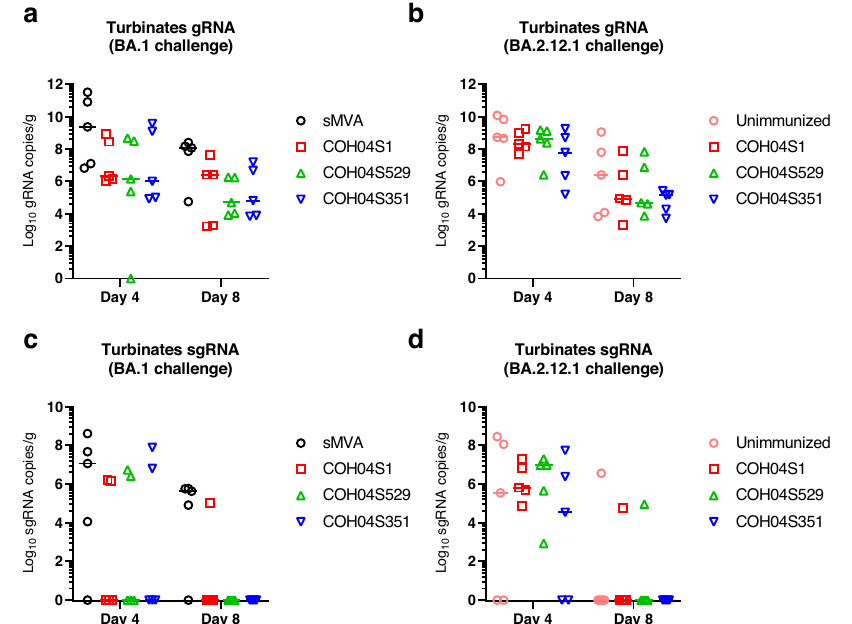
Fig. 4 Viral loads at upper respiratory tracts in COH04S1-, COH04S529-, and COH04S351-vaccinated hamsters following challenge with Omicron BA.1 or BA.2.12.1. SARS-CoV-2 genomic RNA (gRNA, a , b ) and sub-genomic RNA (sgRNA, c , d ) copies were quanti fi ed by qPCR in nasal turbinates of COH04S1, COH04S529, and COH04S351 vaccine and control groups at days 4 and 8 following challenge with Omicron subvariants BA.1 ( a , c ) and BA.2.12.1 ( b , d ). Lines indicate median RNA copies. One-way ANOVA followed by Tukey ’ s multiple comparison test was used following log transformation. When not indicated, differences are not signi fi cant ( p > following viral challenge with BA.1 or BA.2.12.1, with only one or two exceptions in the COH04S1 and COH04S529 vaccine groups that showed low-grade bronchioalveolar hyperplasia (Fig. 5b, e). Lung pathology in all three vaccine groups appeared mostly